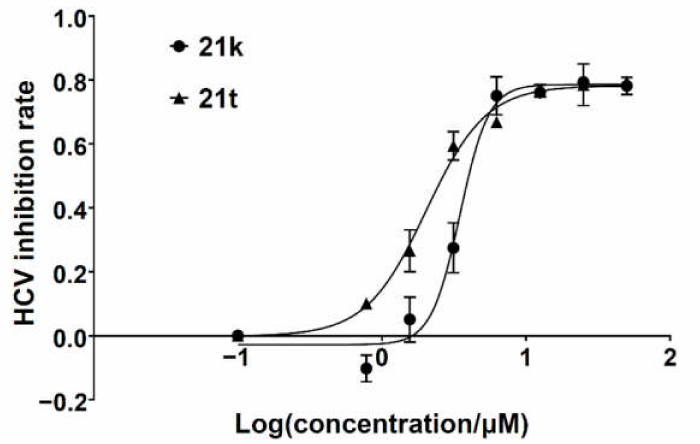
Figure 2. HCV inhibition fitting curves of compounds 21k and 21t